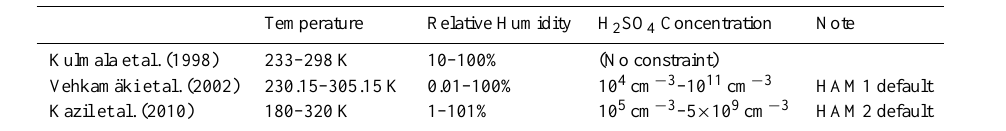
Table 5. Binary aerosol nucleation schemes available in ECHAM-HAM2 and their valid range of thermodynamical conditions. Boundary values are used in case the actual atmospheric condition is out of range.